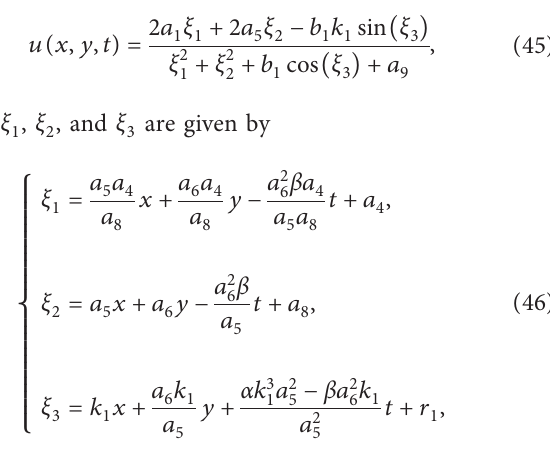
Figure 7: Spatiotemporal structure of solution (45) with the parameter selections: (a) t � − 10, a